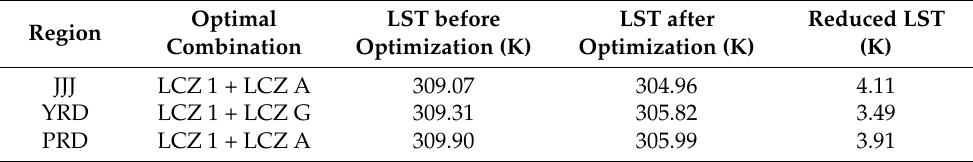
Table 6. The optimal LCZ combinations and LST variations in three urban agglomerations, for summer daytime in 2018. Optimal LST before LST after Reduced LST Region Combination Optimization (K) Optimization (K) (K) JJJ LCZ 1 + LCZ